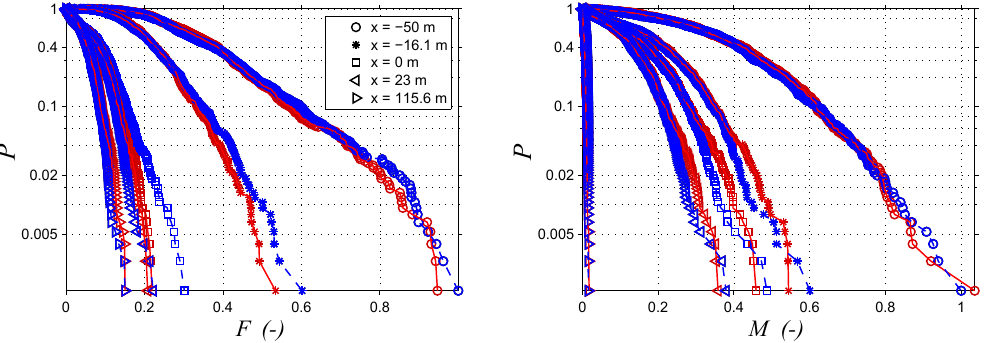
Figure 18. Probability of exceedance of the positive peaks in the time series of the sectional forces and moments for load case 6.1. The forces and moments are normalized with the largest force and moment peak at the seabed in the Flex5 calculation. Blue: Flex5. Red: QuLA.